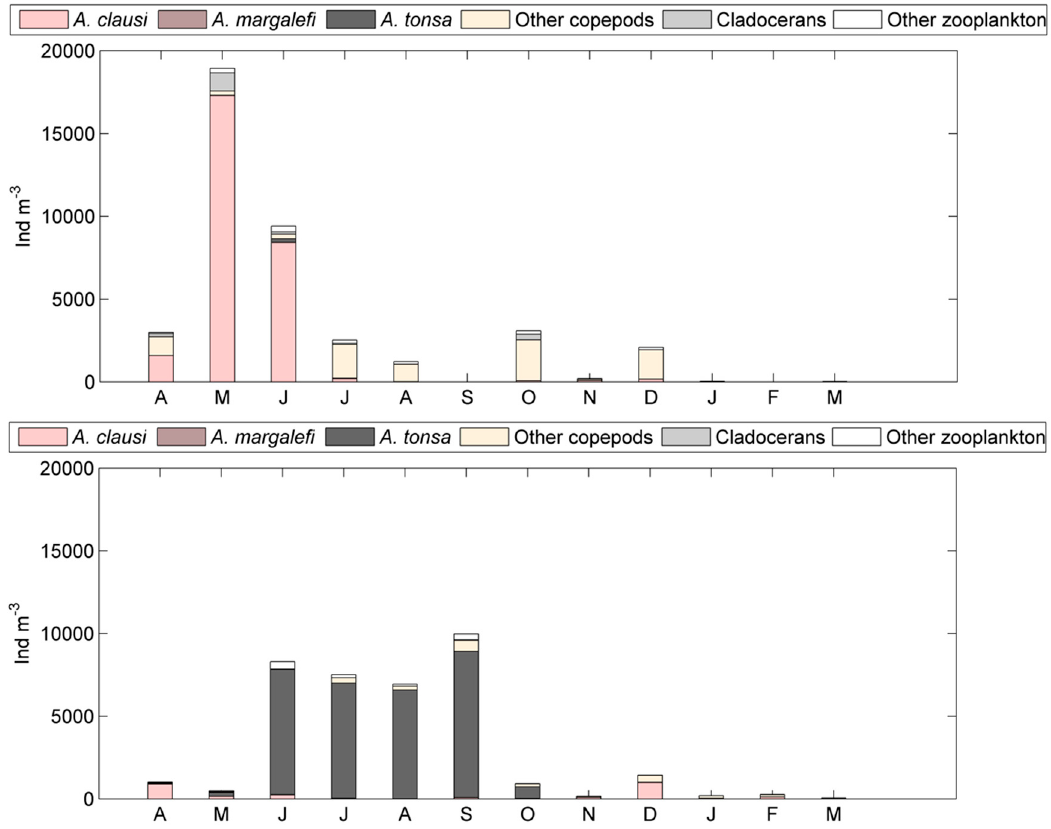
Figure5. Monthlyabundanceof A.tonsa withrespecttoother Acartia speciesandremainingzooplankton at coastal station 1M ( top panel ) and at lagoon stations ( bottom panel ) for the 2003–2004 period. Figure 5. Monthly abundance of A. tonsa with respect to other Acartia species and remaining zooplankton at coastal station 1M ( top panel ) and at lagoon stations ( bottom panel ) for the 2003–2004 A match between abundances and distribution of A. tonsa and environmental parameters emerged period. from the Kendall rank correlation test for DS3 (Table 4), which showed that A. tonsa was the only species of dominant copepods positively and significantly correlated with temperature, phytoplankton, POC and Chl a concentrations, as well as A . margalefi species. However, the positive correlation of A. margalefi with POC was not significant. With respect to the same parameters, the congener A. clausi showed the opposite correlation and was not statistically